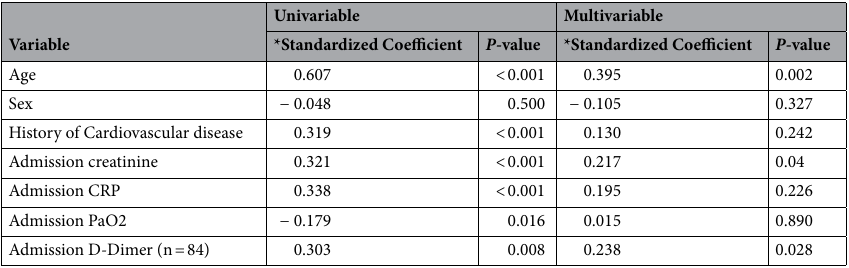
Table 6. Determinants of admission hsTnT levels by linear regression analysis. *Coefficients correspond to 1-unit change in natural log transformed hs Troponin.